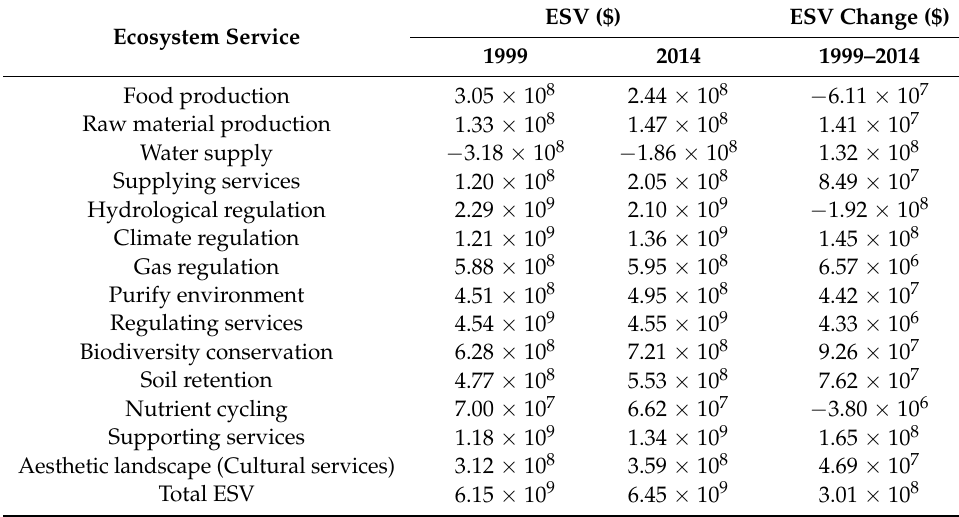
Table 7. Ecosystem service value ($) in 1999 and 2014, and the ecosystem service value change between 1999 and